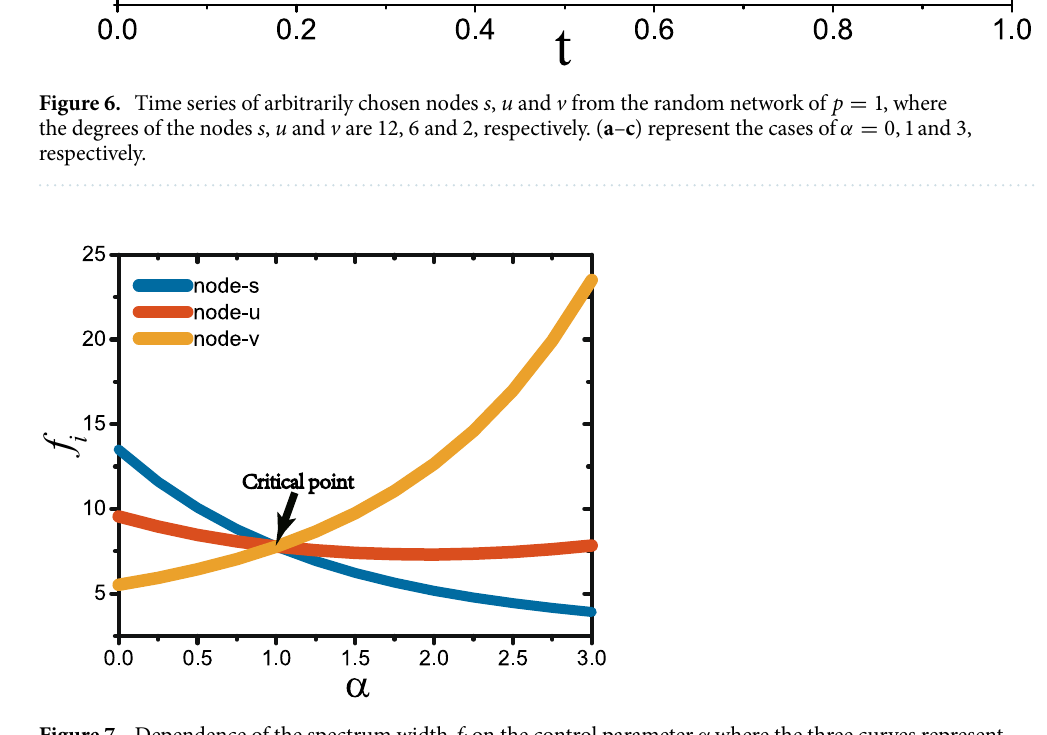
Figure 7. Dependence of the spectrum width f i on the control parameter α where the three curves represent the cases of nodes s , u and v ,